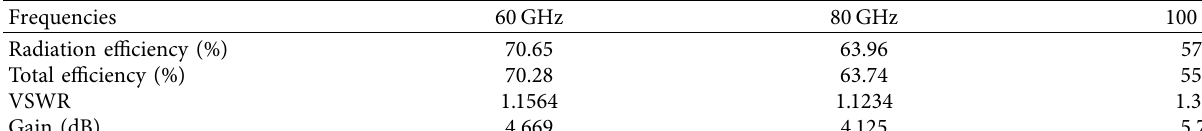
Figure 5: Free space voltage standing wave ratio curve. Table 2: Gain and radiation efficiency.